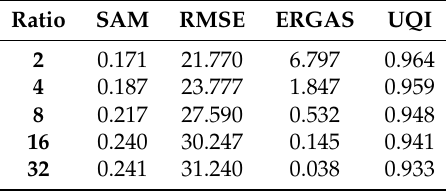
Table 6. Spectral quality indexes applied to Landsat test set with training inputs of 581 × 419 (Ratio